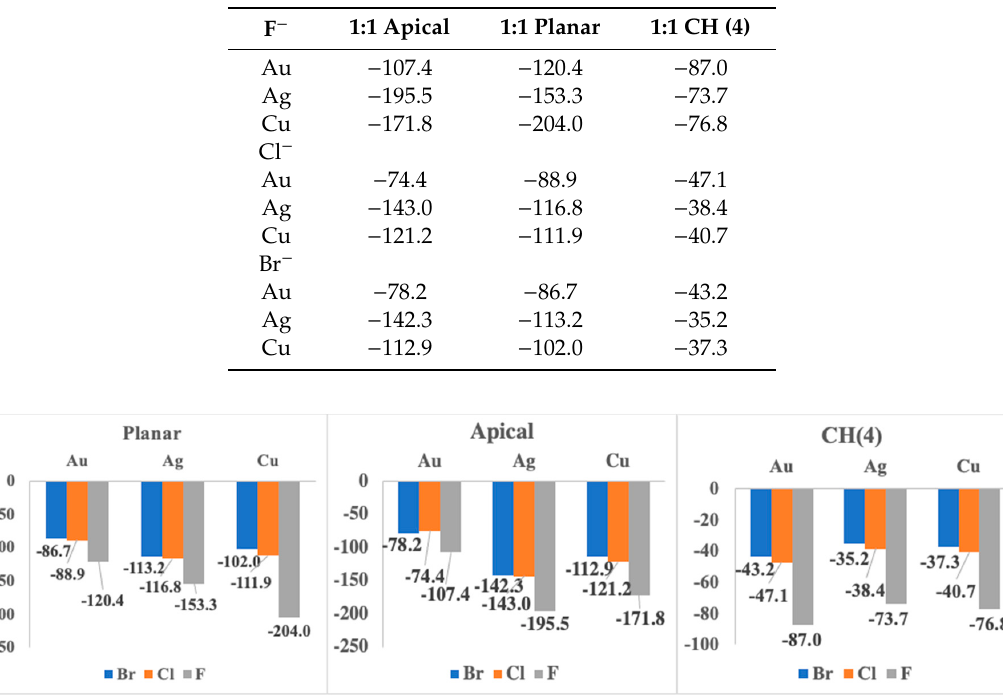
Table 1. Binding energy, E b , (kJ mol − 1 ) for the 1:1 complexes.